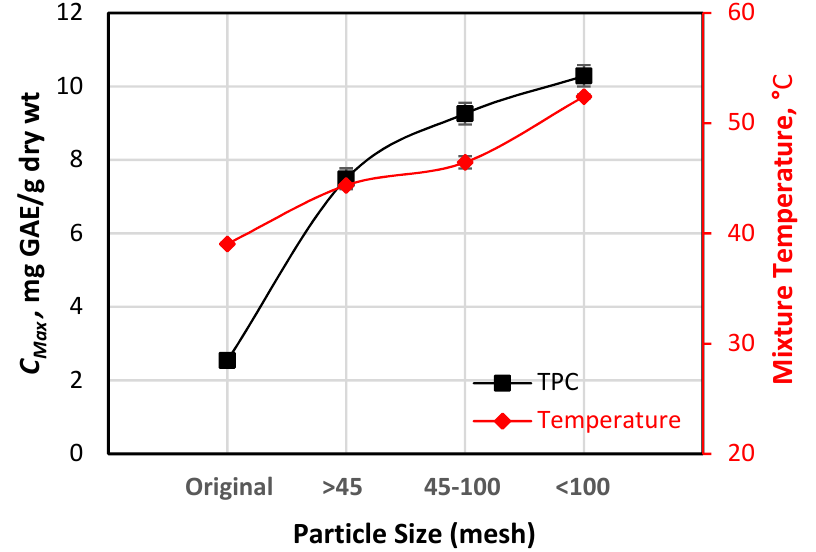
Figure 5. Relationship between the maximum yield, C Max , and the particle size of the potato peels during DUAE under the conditions of: ultrasonic power 120 W, frequency 22.95 kHz, bath tempera- ture 25 ◦ C; solvent-to-solid ratio 40:1; and extraction time 30 min. The particle sizes in corresponding to the mesh size are original (20–30 mm); >45 mesh (>0.354 mm); 45–100 mesh (0.150–0.354 mm), and <100 mesh (<0.150 mm).